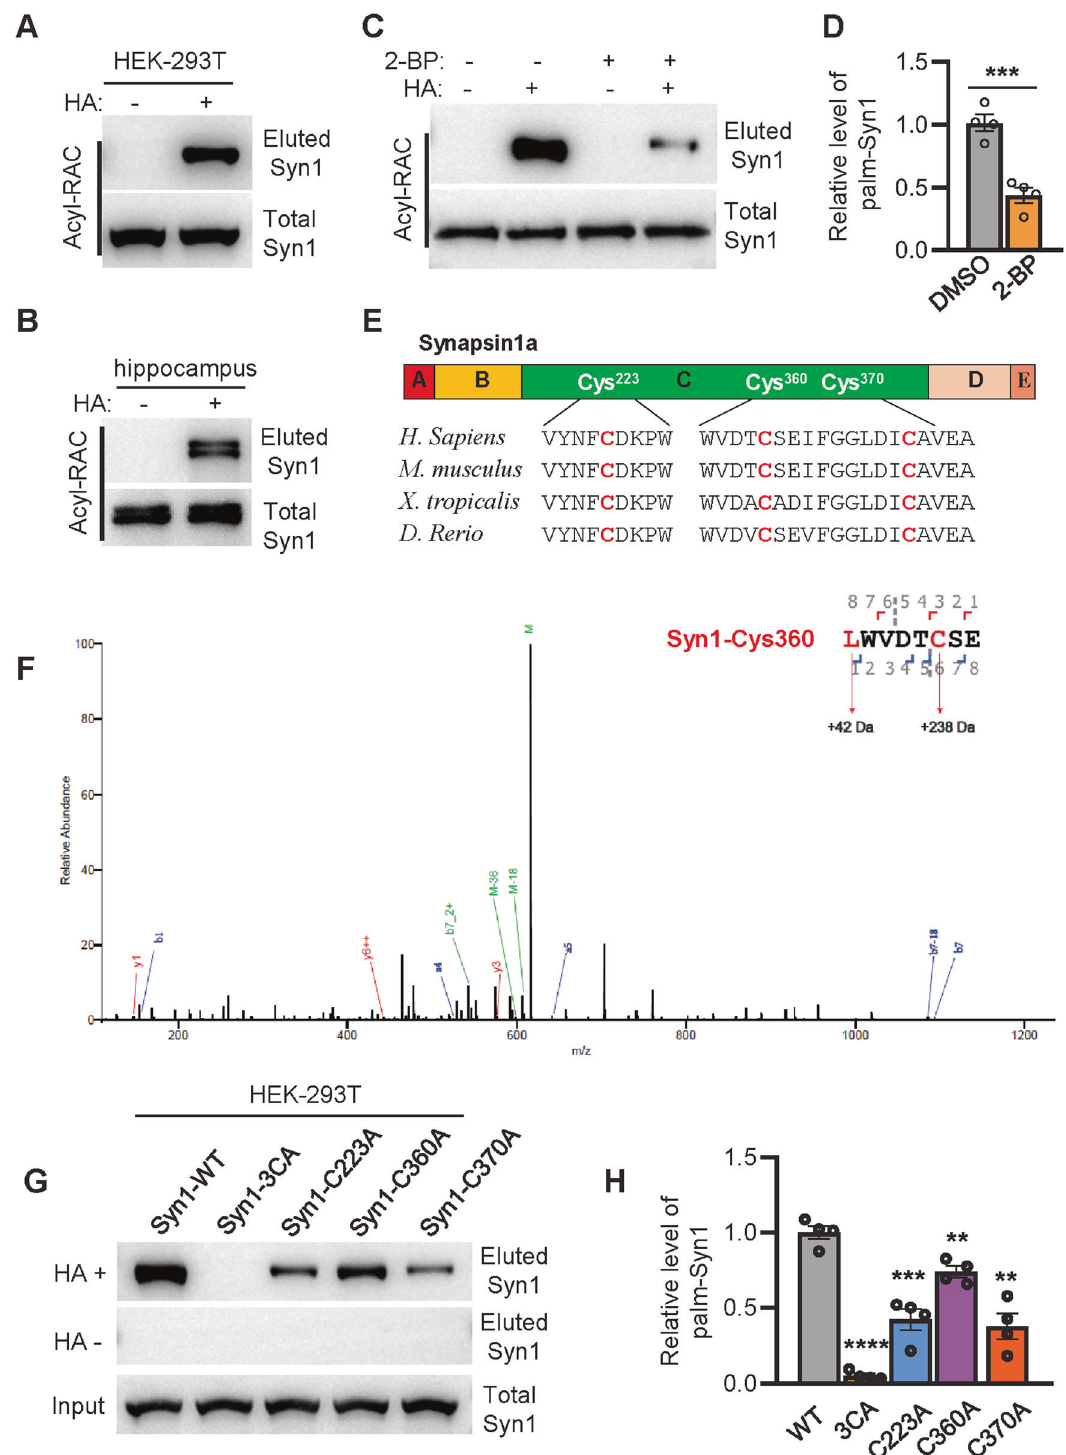
Fig. 1 Syn1 is palmitoylated at Cys-223, Cys-360, and Cys-370. A , B Syn1 expressed in HEK-293T cells or lysate of mice hippocampi was analyzed for protein palmitoylation by Acyl-RAC assay. HA + , with NH 2 OH, HA-, without NH 2 OH. C , D HEK-293T cells expressing Syn1-his was incubated with 50 μ M 2-BP for 8 h and evaluated for the level of palm-Syn1. *** p < 0.001; t -test ( n = 4 biological replicates). E Protein sequences of Syn1 from various species were aligned for analyzing cysteine conservation. F Puri fi ed Syn1- fl ag was probed by mass- spectrometry, a mass-shift of 238 Da linked to cysteine is a hallmark for palmitoylation, suggesting that cysteine-360 is palmitoylated. G , H His- tagged Syn1-WT and its mutants were analyzed by Acyl-RAC for the level of palm-Syn1. ** p < 0.01; *** p < 0.001; **** p < 0.0001; one-way ANOVA; n = 4 biological replicates, Data are mean ±